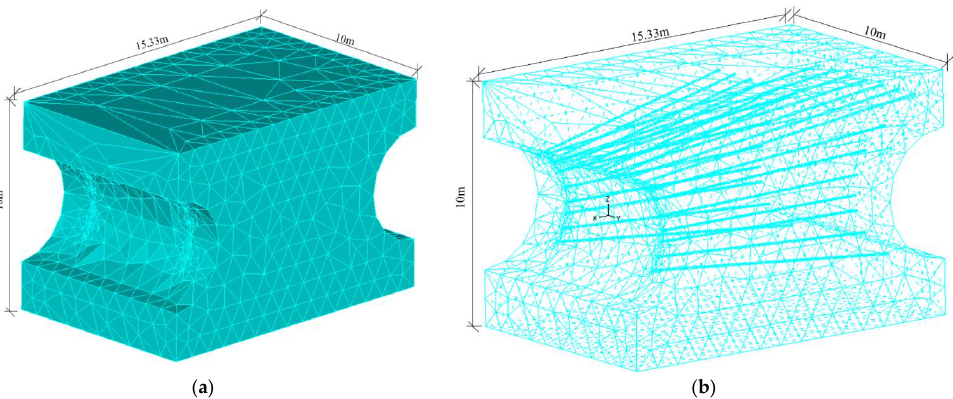
ent thermal model with phase transition. Adiabatic boundary conditions were set on the outer boundary of the domain were set on the outer boundaries of the domain.